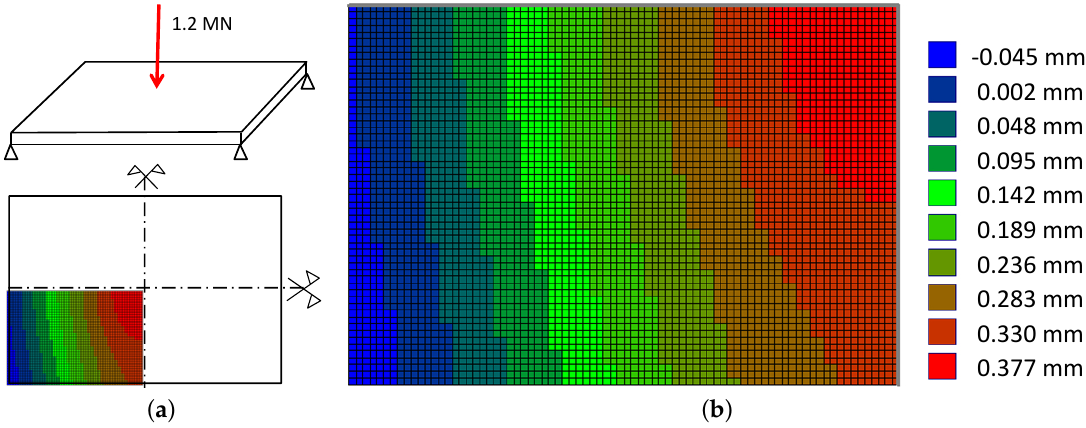
Figure 8. Doubly symmetric FE simulation of the top steel plate: ( a ) A pressure of 1.2 MN simulates the load of a steel post and loads the center of a rectangular steel plate; ( b ) Deflection of one quarter of the plate in the load